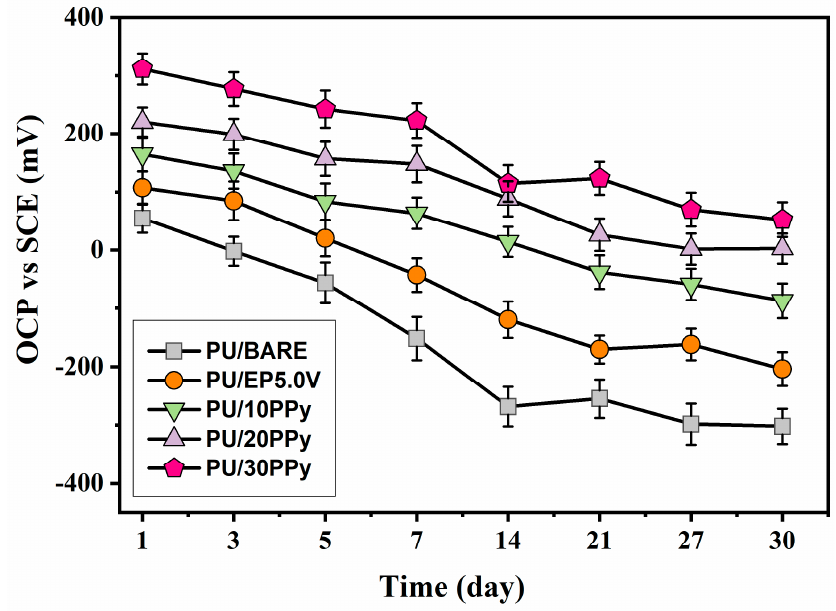
Figure 7. OCP values of prepared coatings on passivated and bare specimens in a 3.5% NaCl solution in different immersion periods (error bars represent the standard deviation of triplicates).